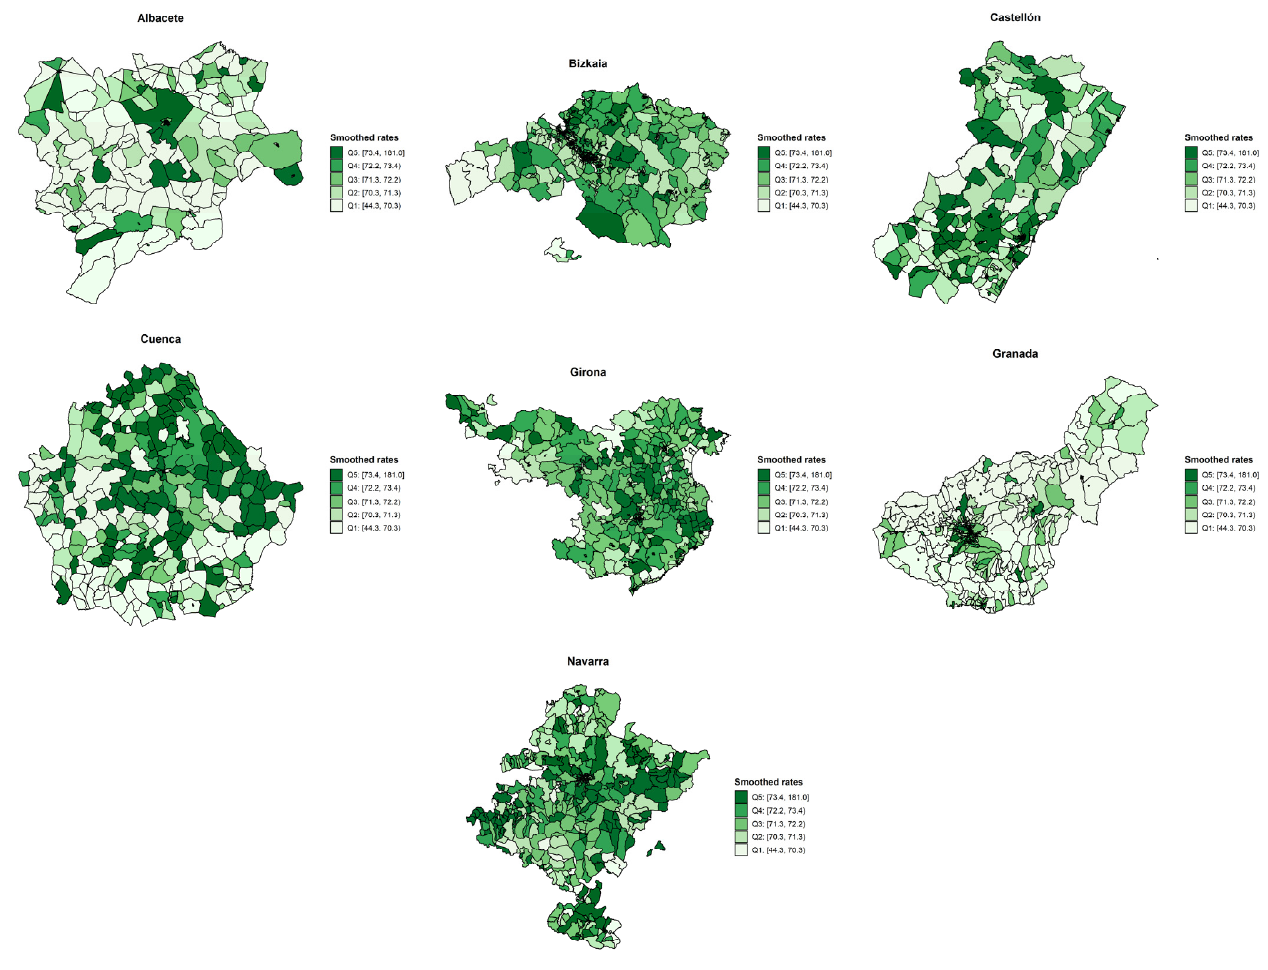
Figure 2. ( a ) Observed colorectal incidence rates and ( b ) smoothed cancer incidence rates adjusted for deprivation and age by census tract in seven Spanish provinces during the period 2010–2013.